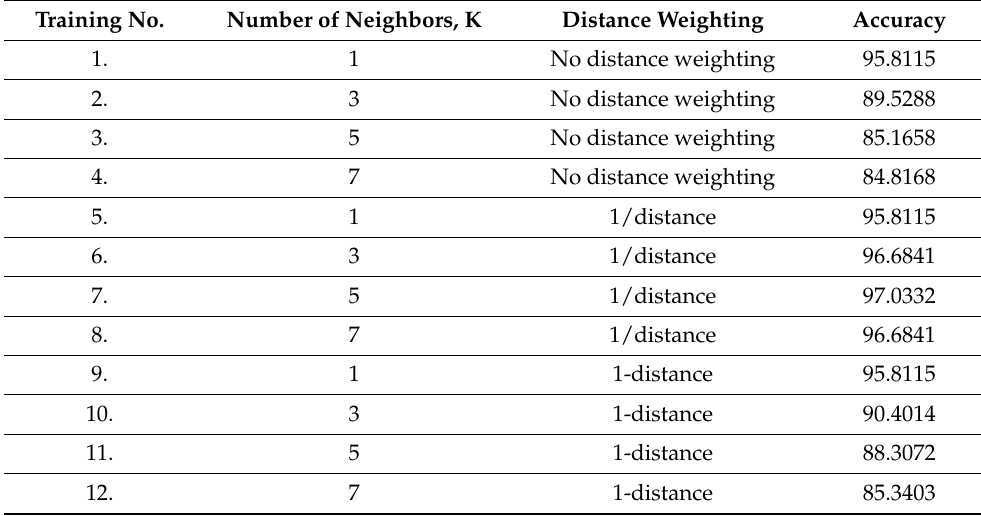
Table 9. Prediction accuracy of k-nearest neighbor hyperparameter optimization.